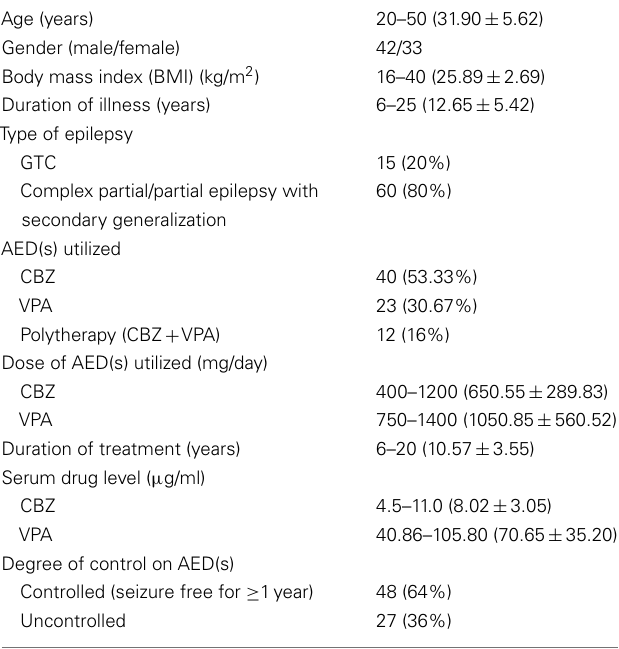
Table 1 | Demographical and clinical features of the studied patients